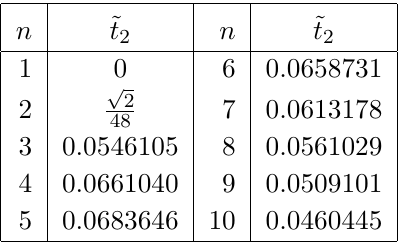
Table 4 . Numerical values of ~ t 2 for j = m = 0 (from ref.